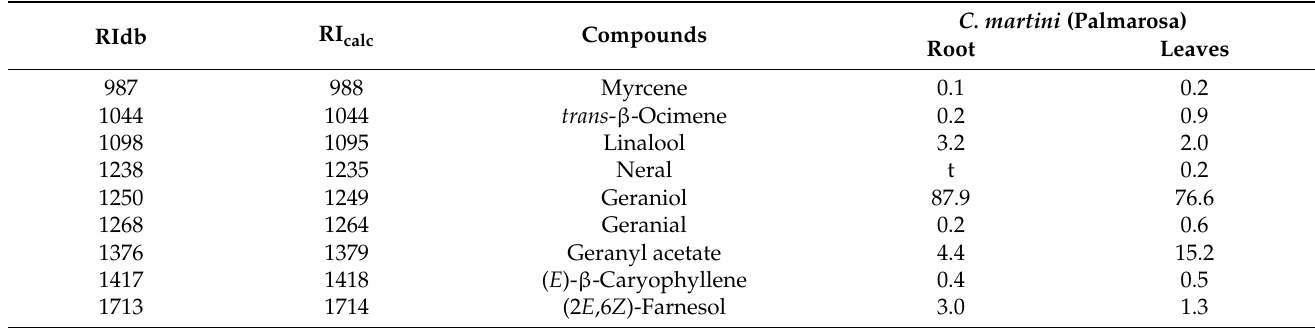
Table 4. Selected constituents of C. martini essential oils extracted from roots and